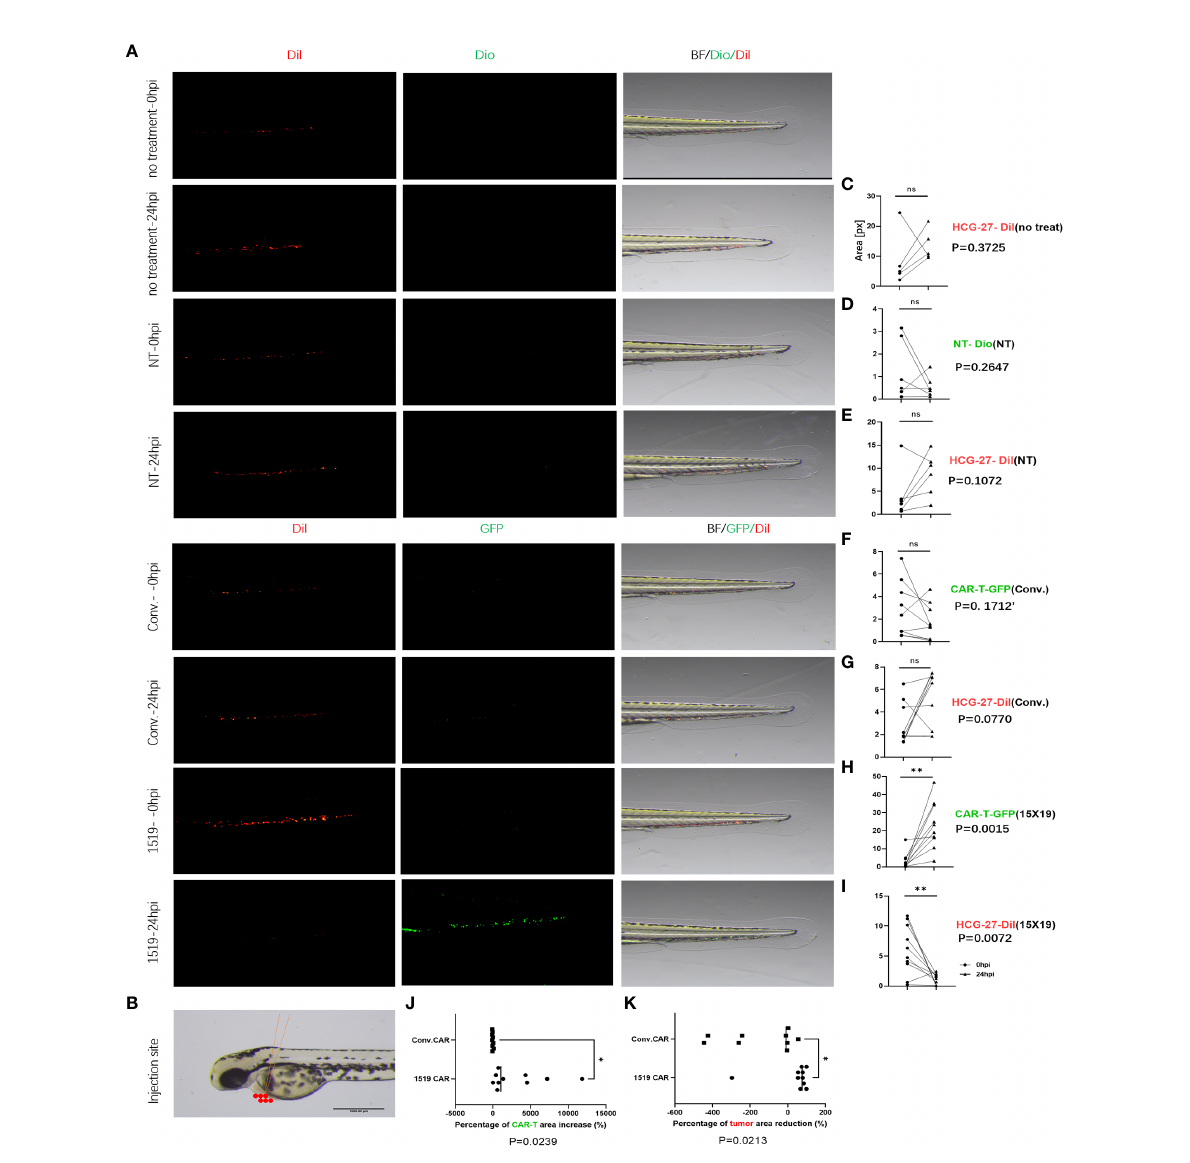
FIGURE 9 Elimination of metastatic cancer cells by 15×19 CAR T cells. (A) Zebra fi sh model of metastasis. Gastric cancer HCG-27 cells (red) are injected into the perivitelline space of zebra fi sh to induce extensive cancer metastasis in zebra fi sh. Then, immune cells (green) are injected into the same site. Cell staining and the time points of observation are the same with the in situ cancer; (B) , A diagrammatic sketch of tumor cells and effector cells injection into the perivitelline space, scale bar = 1000 m M; (C) , No shrinking of the metastatic tumors in the untreated group 24 hours post-injection; (D) , NT cells rarely reach the metastatic cells in the NT group, and the cell numbers do not increase 24 hours post-injection; (E) , No reduction is seen in the number of metastatic tumors in the NT group 24 hours post-injection; (F) , conv.CAR T cells rarely reach the metastatic cells in the conv.CAR T group, and the cell numbers do not increase 24 hours post-injection; (G) , No reduction is seen in the number of metastatic tumors in the conv.CAR T group 24 hours post-injection; (H) , A large number of 15 × 19 CAR T cells reach the metastatic site and amplify greatly 24 hours post-injection; (I) , A signi fi cant reduction is seen in the number of metastatic tumors in the 15 × 19 CAR T group 24 hours post-injection. (J) , Signi fi cantly more 15×19 CAR T cells than conv.CAR T cells; (K) , A higher reduction is seen in the number of metastatic cancer cells in the 15 × 19 CAR T group than in the conv.CAR T. Analyzed for statistical signi fi cance by paired Student ’ s t test. * P < 0.05; ** P <